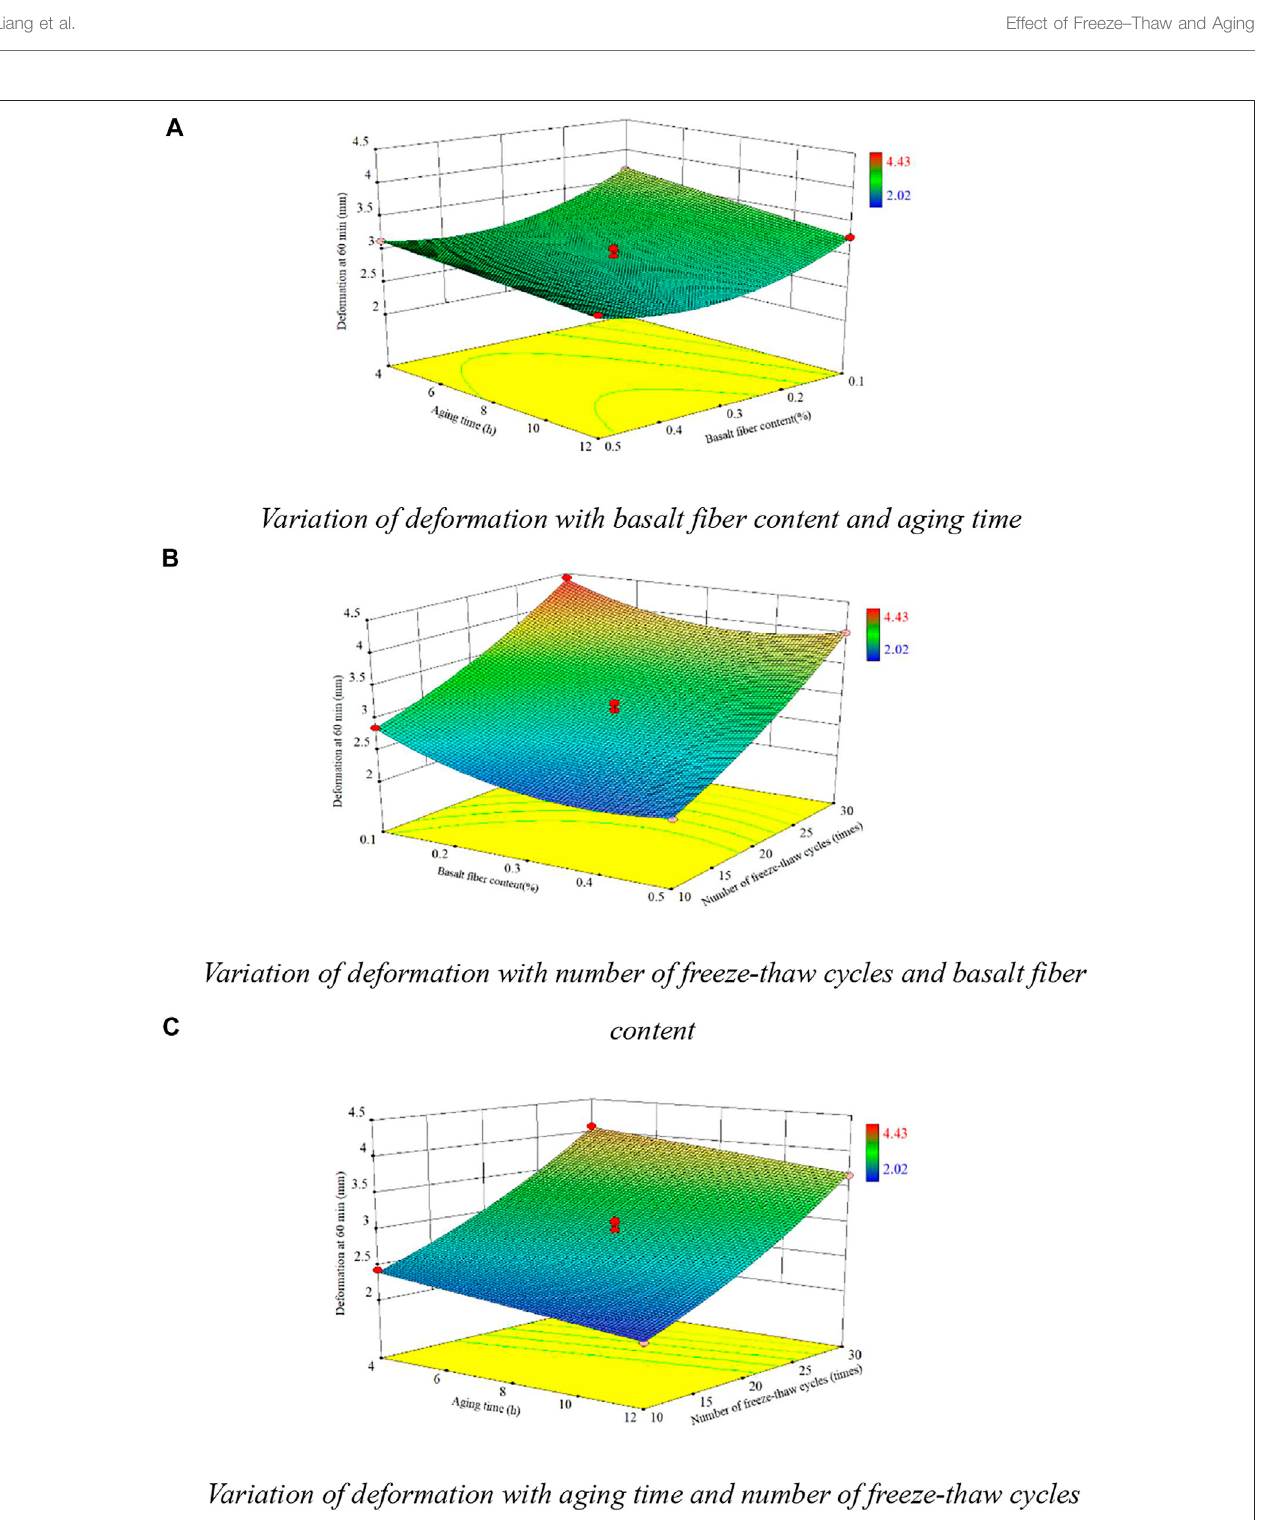
FIGURE 5 | Test result of deformation. (A) Variation of deformation with the basalt fi ber content and aging time. (B) Variation of deformation with the number of freeze-thaw cycles and basalt fi ber content. (C) Variation of deformation with aging time and the number of freeze-thaw cycles.